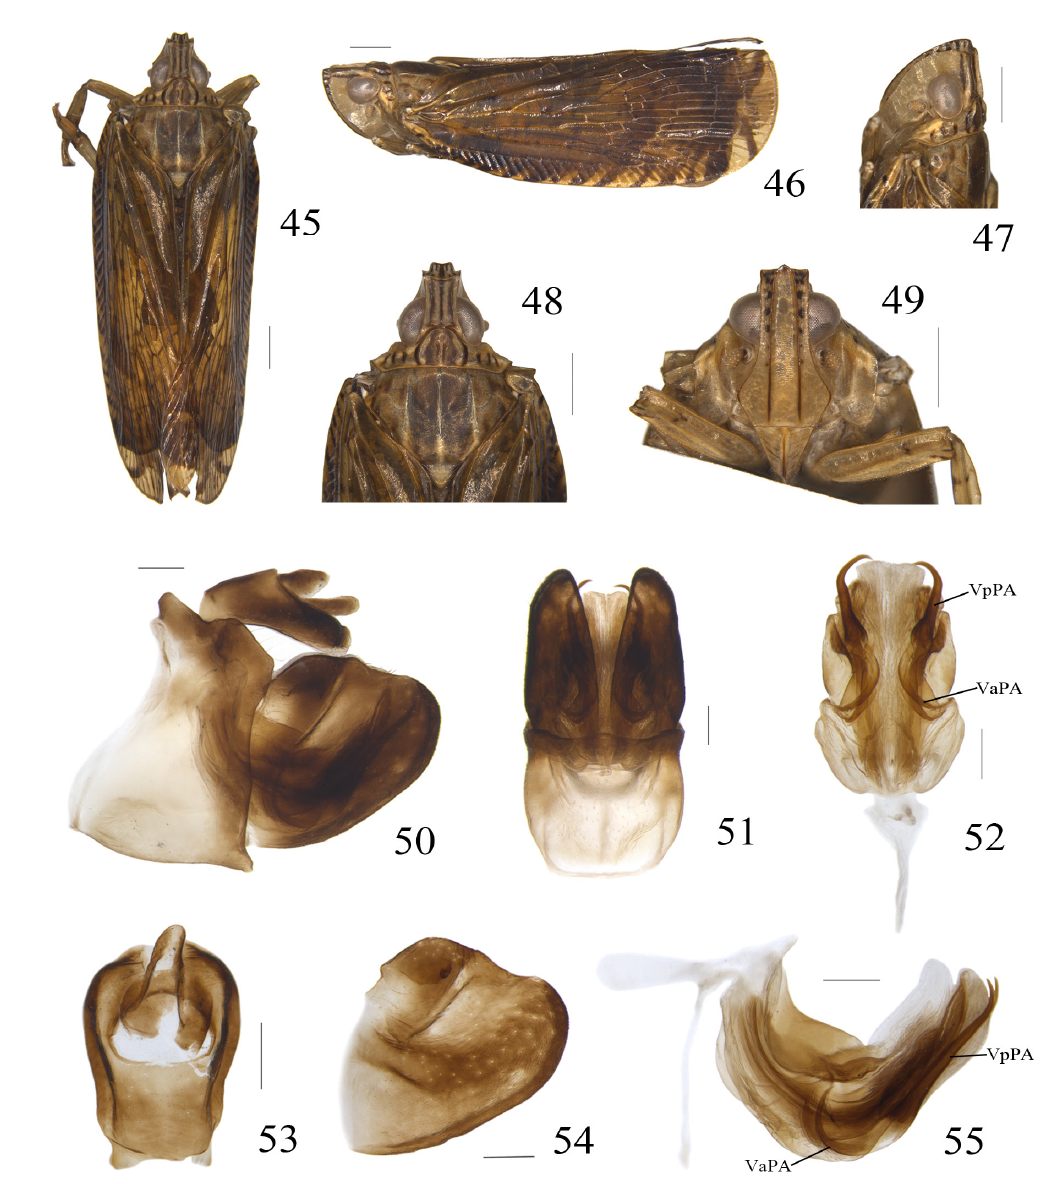
Figs 45–55. Serida parenthesisflexuosa Wang & Soulier-Perkins, sp. nov., holotype, ♂. 45 . Habitus, dorsal view. 46 . Habitus, lateral view. 47 . Head, lateral view. 48 . Head and thorax, dorsal view. 49 . Frons and clypeus. 50 . Male terminalia, lateral view. 51 . Male terminalia, ventral view. 52 . Phallic complex, ventral view. 53 . Anal tube, dorsal view. 54 . Gonostylus, lateral view. 55 . Phallic complex and tectiform structure, lateral view. Scale bars: 45–49 = 1 mm; 50–55 = 0.2